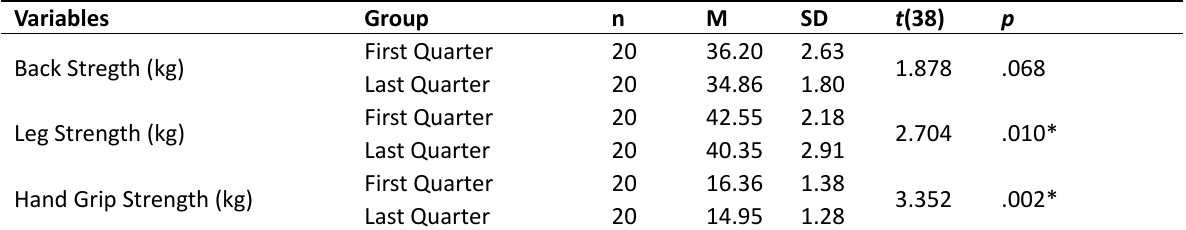
Table 2. The comparison of absolute muscular strength performance between the relative age groups. Variables